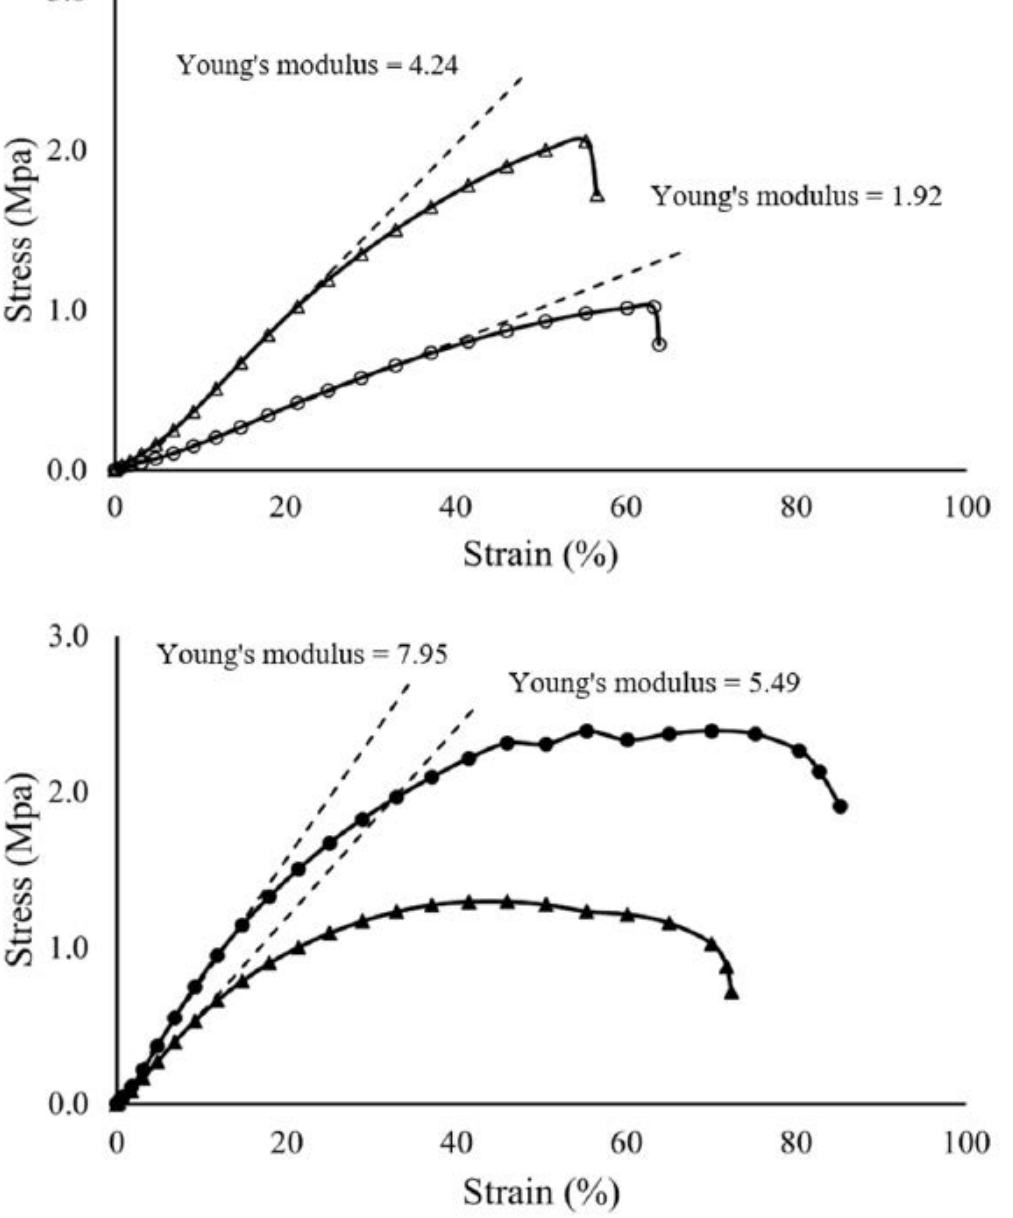
Figure 4. Stress–strain curves ( n = 3) for: the 5% PCL membrane ( ), 5% PCL membrane with CaCO 3 NPs ( (cid:52) ), 10% PCL (cid:35) membrane ( • ) and 10% PCL membrane with CaCO 3 NPs ( (cid:78) ). The dashed lines are the trend of stress growth along with the increase of strain in the linear elastic region, indicating the Young’s modulus of each